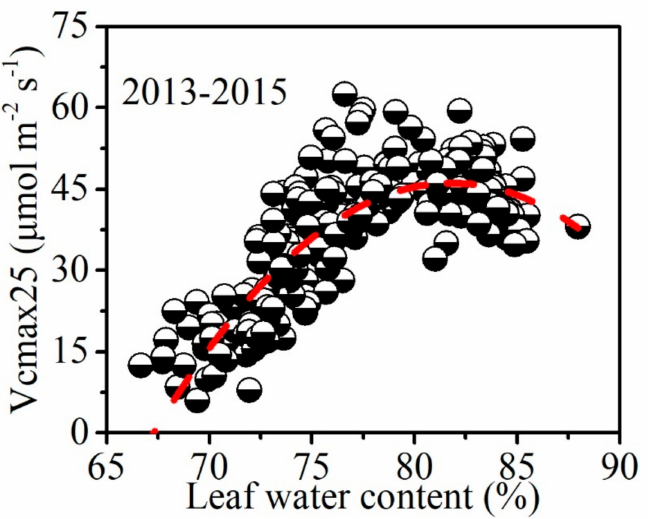
Figure 4. Relationship between LWC and Vcmax25 during